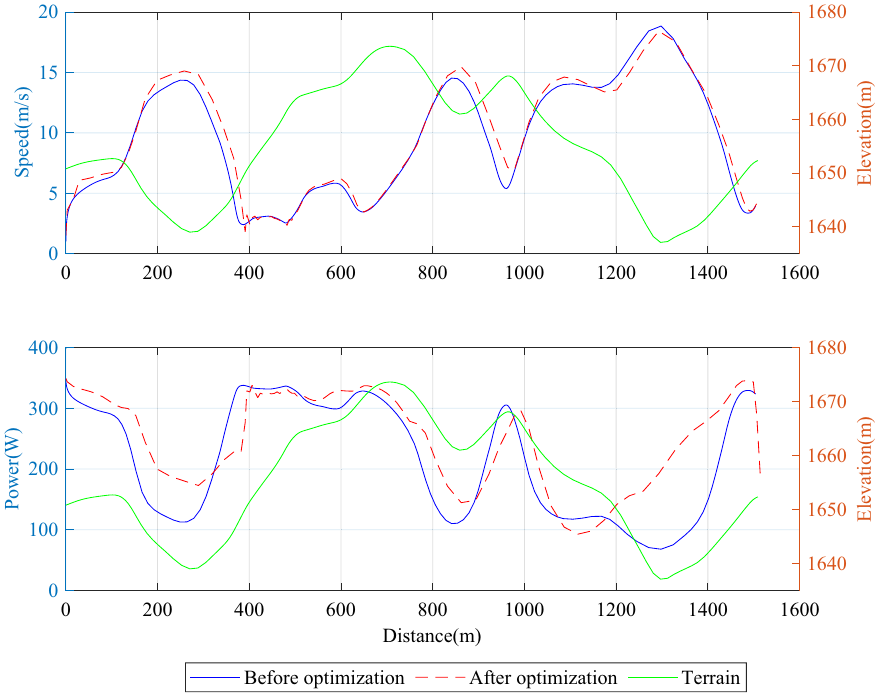
Figure 10. Global speed and driving power distribution of athlete A before and after